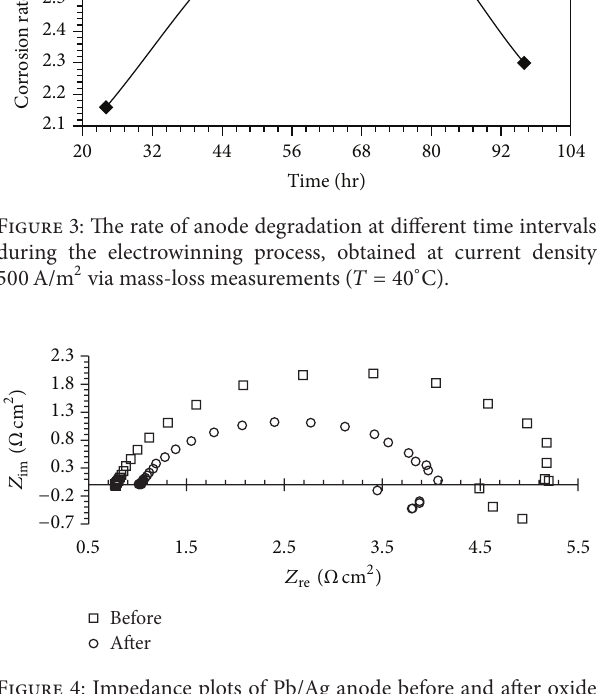
Figure 4: Impedance plots of Pb/Ag anode before and after oxide layer formation upon the electrode surface ( 𝑖 = 500 A/m 2 , 𝑇 = 40 ∘ C).